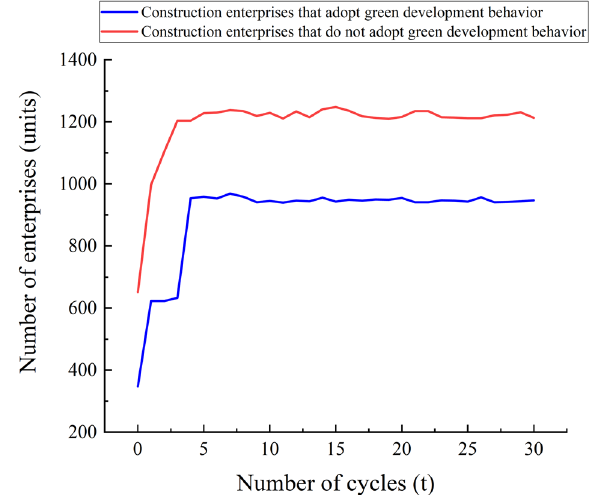
Fig. 4 The dynamic process of adopting green development behaviors in construction enterprises in the experimental group. The moment marked with dotted line in the fi gure represents that in the initial situation of A = 35%, the proportion of construction enterprises adopting green development behaviors in the model is consistent with that of those not adopting green development behaviors.